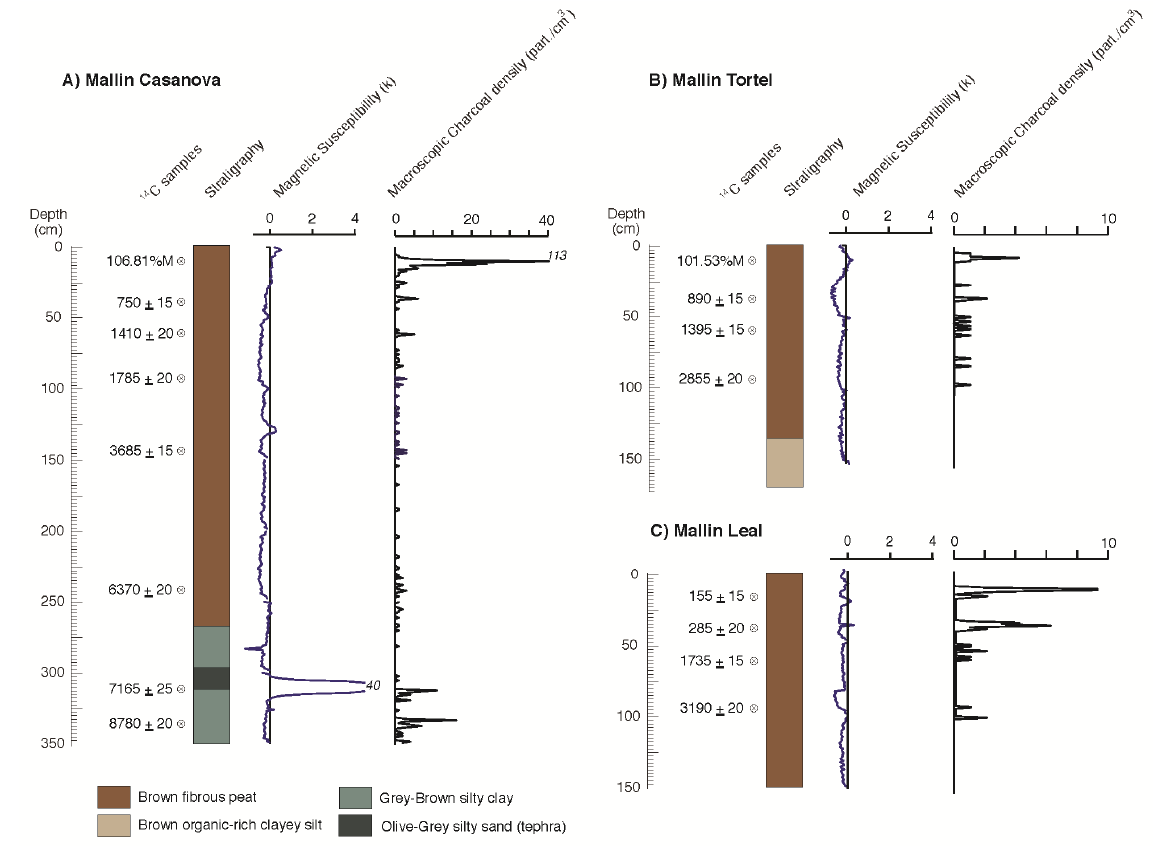
Fig. 2 . 2 Fig. 2. Radiocarbon dates, stratigraphy, magnetic susceptibility, and macroscopic charcoal of each of the three sampled peats: (a) Casanova, (b) Tortel, and (c)